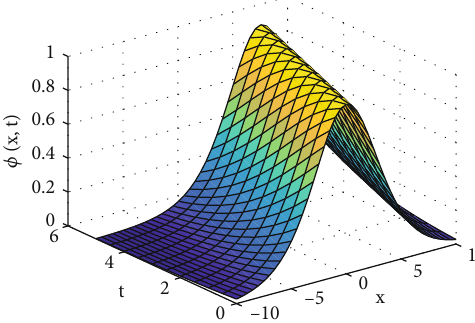
Figure 4: 3D image of numerical results of time fractional BBMB- equation for x ε ½ − 10, 10 (cid:2) , α = 0 : 5 , Δ t = 0 : 011 , β = 1 , and h = 0 :